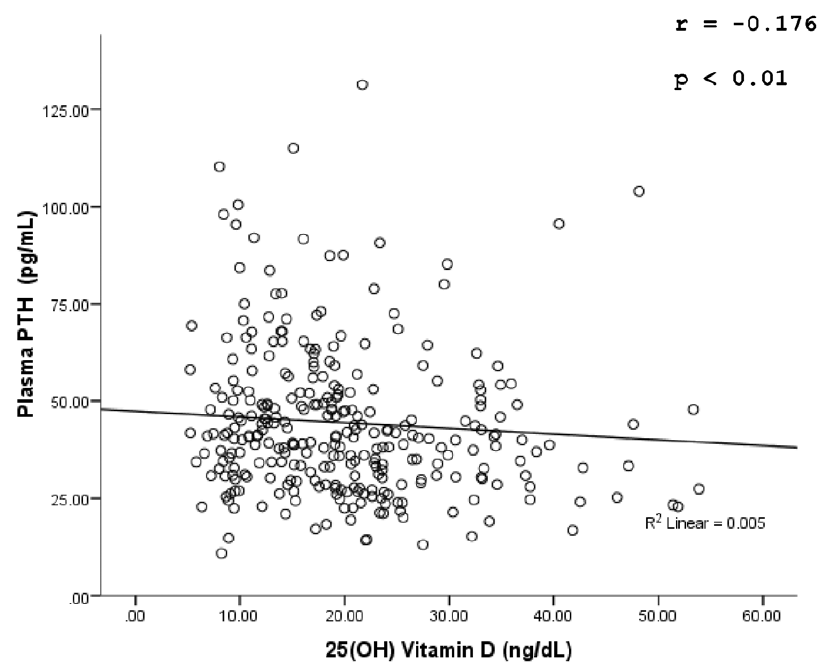
Figure 2. Scatter plot showing negative correlation between vitamin D and PTH.